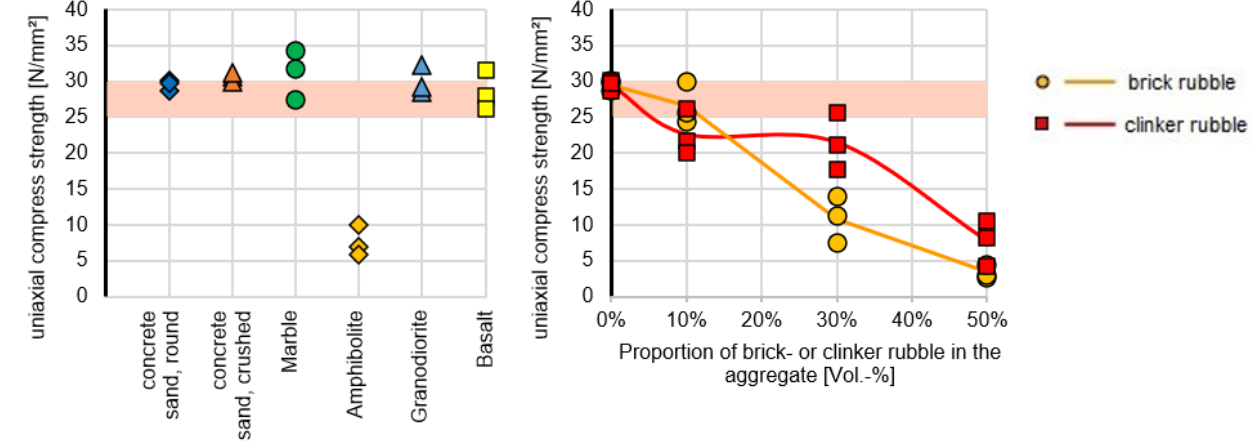
Figure 5. Results of unconfined compressive strengths of the base formulation with m-sand options.